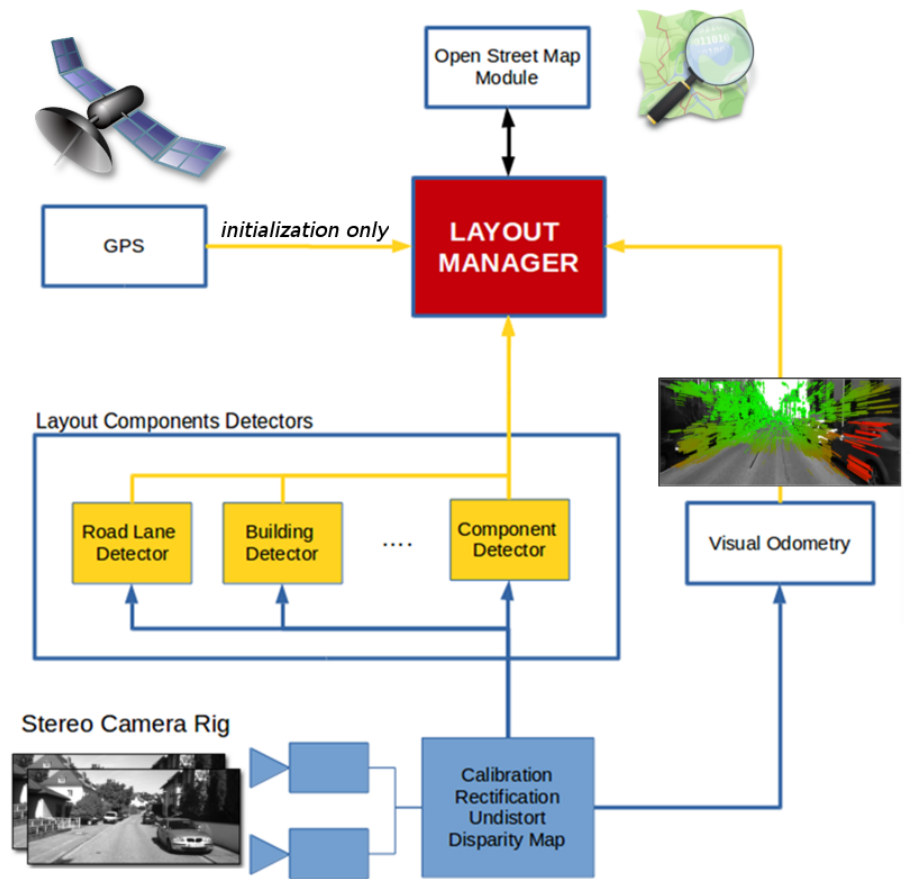
Figure 5. Proposed Road Layout Estimation framework schematics. The inputs are a couple of stereo images and the OpenStreetMap road network[28]. The layout manager box corresponds to the set of localization hypotheses (LHs), each of which receives inputs from ad-hoc detection pipelines. These data are used in order to create the vector of LC associated with each of the hypotheses. The contribution of this paper consists of a new building detector block, i.e., a new LC used within the LH evaluation. Intuitively, the better score the LH has, the better the localization of the vehicle is. Please notice that the GPS is used during the initialization phase